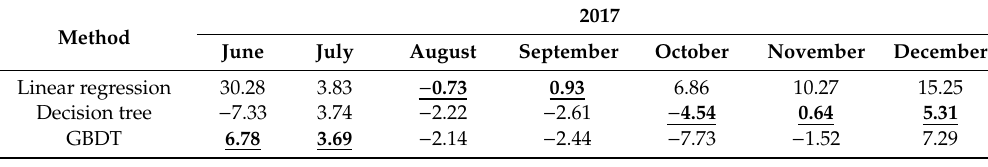
Table 16. Peak error for each method per month. (bold and underline means a best value of each month). Method Linear regression Decision tree Table 17. NMBE for each method per month. (bold and underline means a best value of each month). Method Linear regression Decision tree